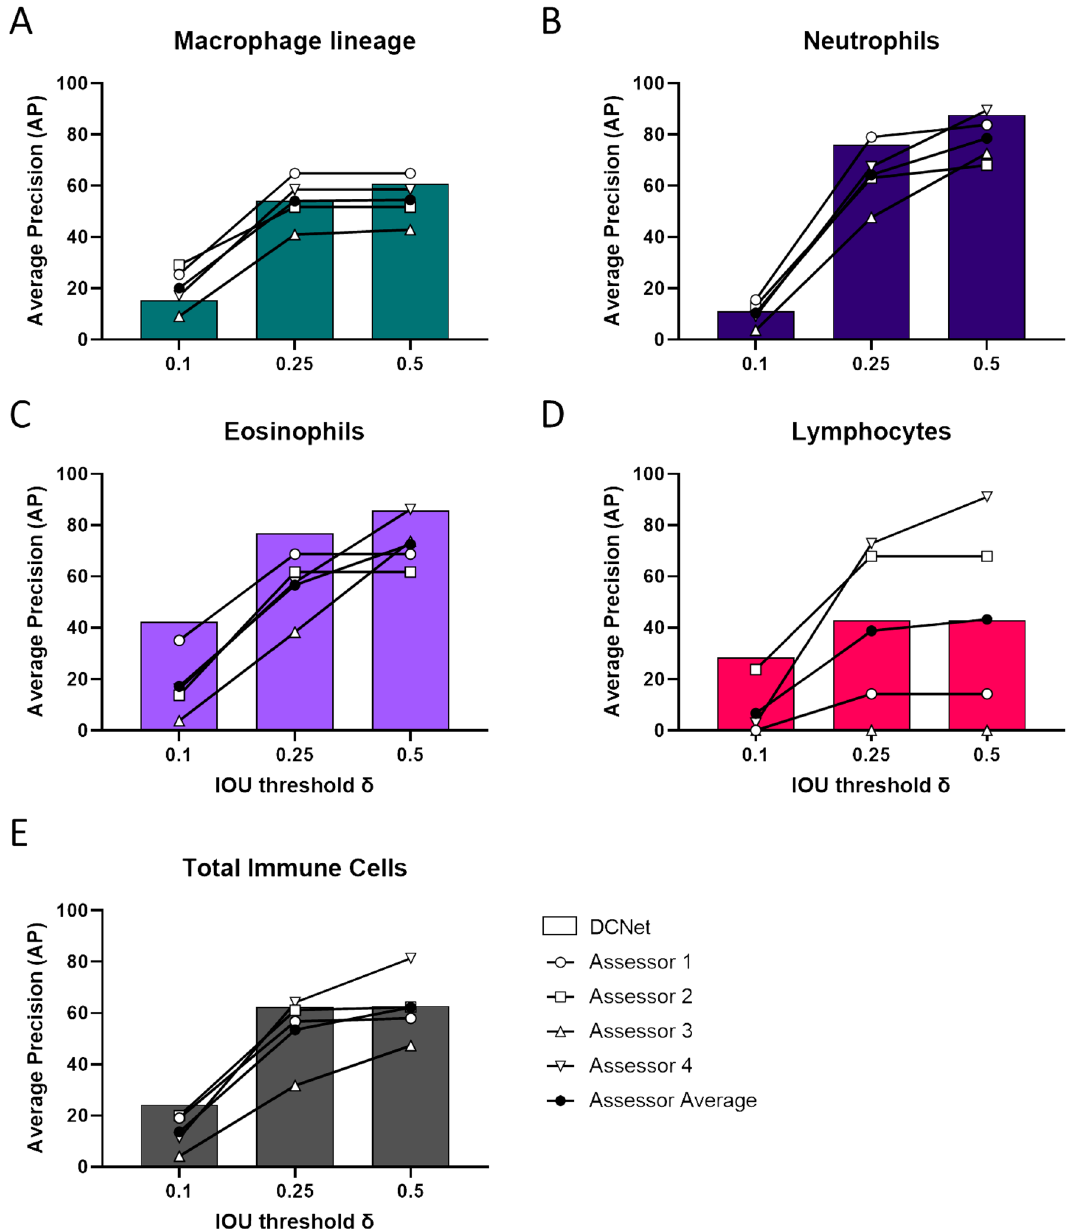
Figure 4. DCNet matches human assessors at immune cell classification. The average precision (AP) of DCNet predicted classifications was calculated as intersection over union (“IoU”) at thresholds to find true positives, relative to the distance from the ground truth in the cell centre. A δ = 0.5 means the predicted centre point lies within half a cell σ diameter away from the ground truth. This was also calculated for human assessors based upon their annotation and plotted for comparison for each immune cell class ( A–D ) and total immune cell population ( E